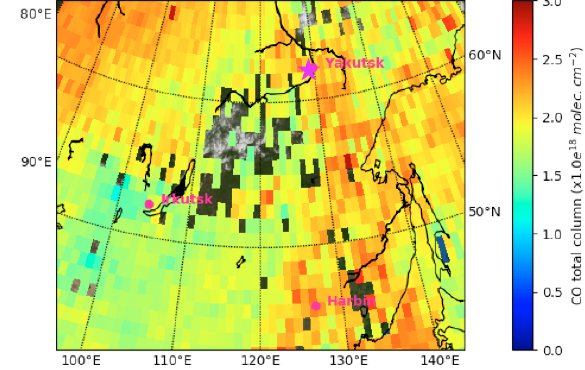
Figure 24. As Figure 5a for the time period 16–19 July